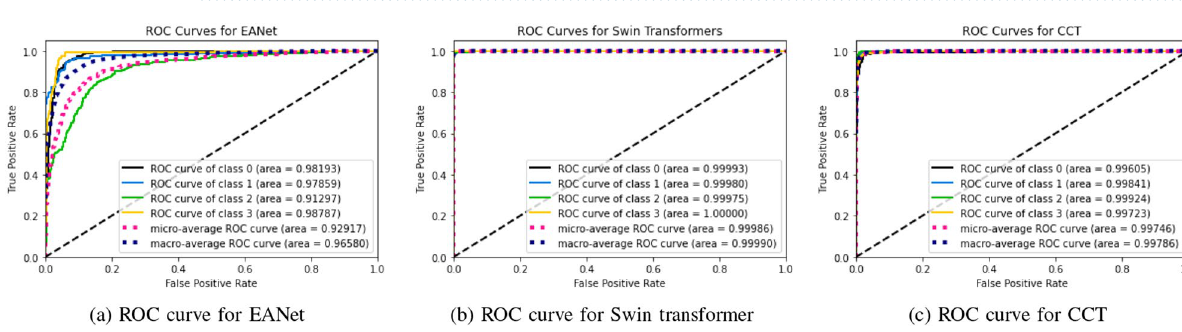
Figure 12. ROC curves for Transformer Based Models Used in Our study.